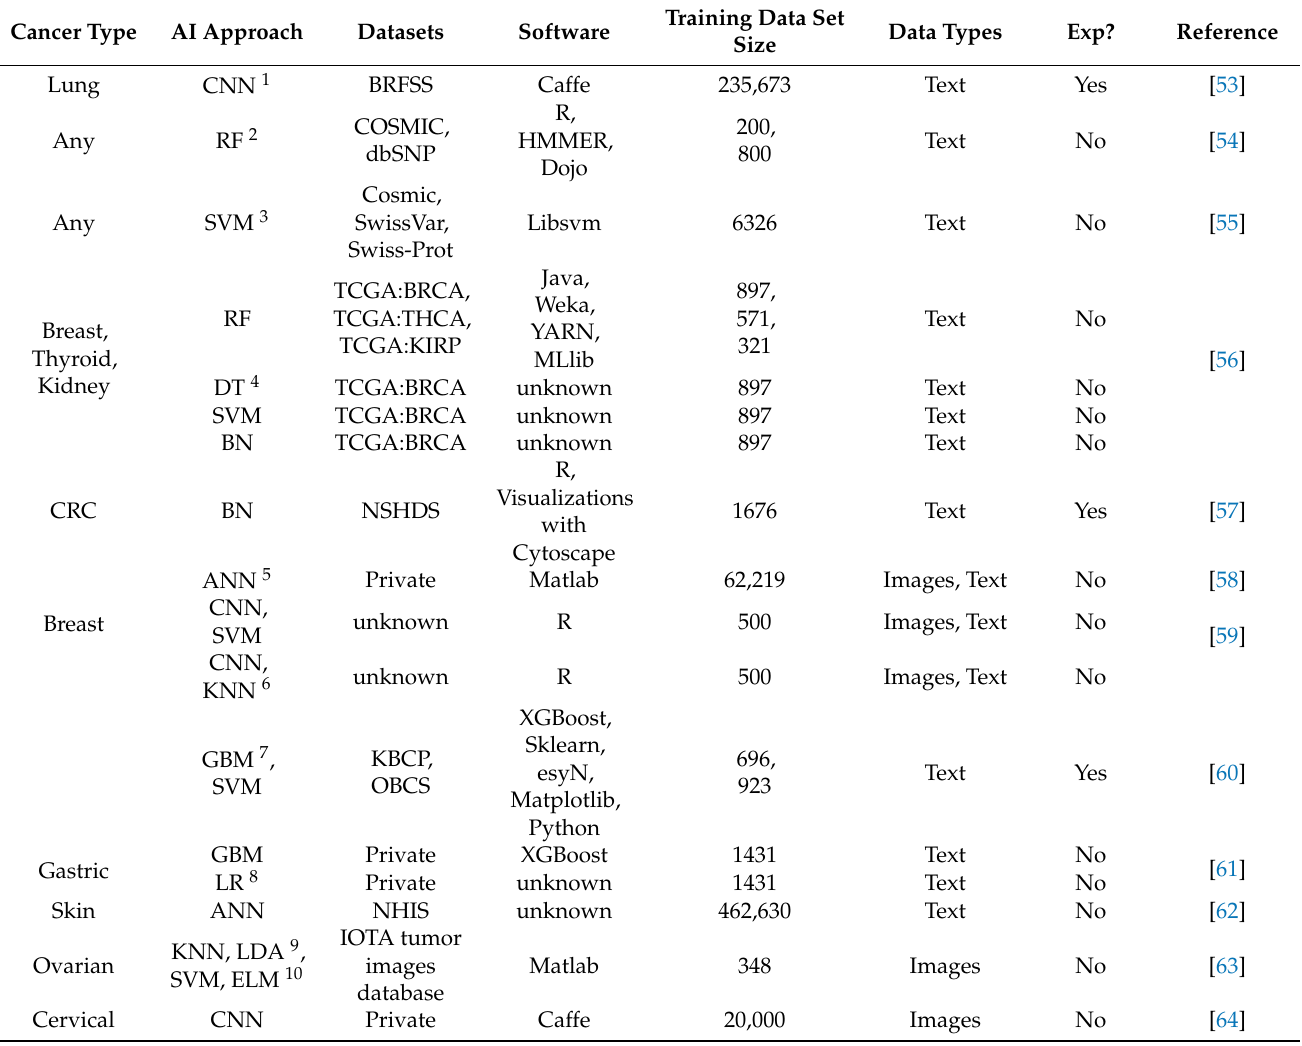
Table 1. Review of publications whose main topic is Machine Learning and cancer risk